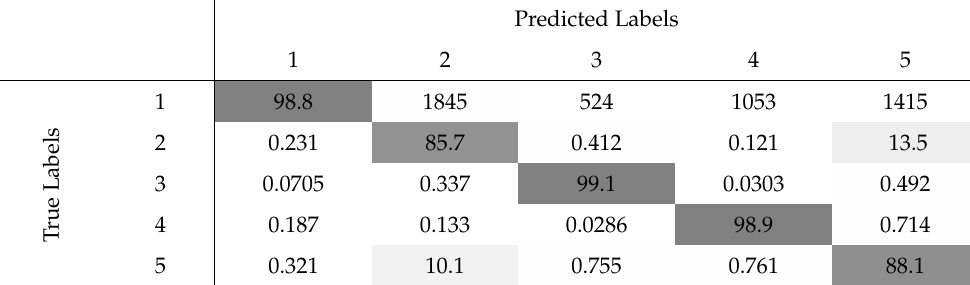
Table 6. Experiment II: Confusion matrix of our neural network.